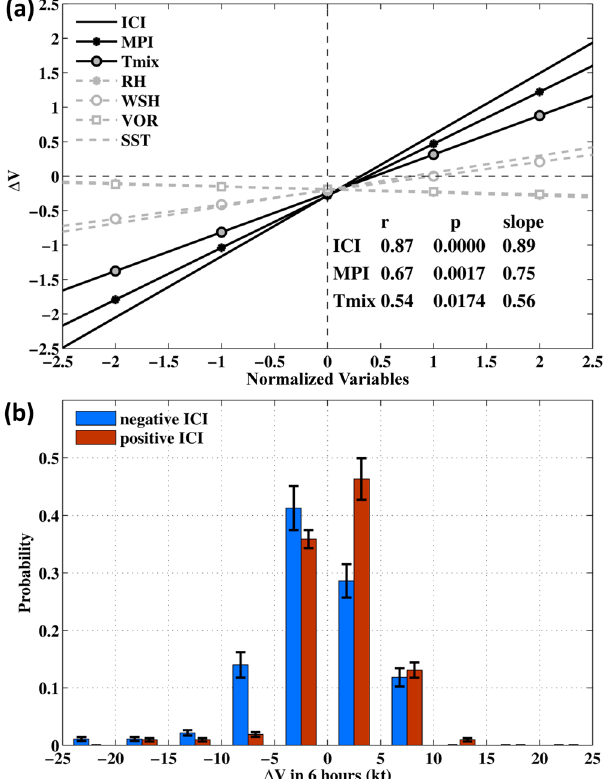
Figure 5. ( a ) Regression lines of normalized (by s.d. σ ) 6-hourly intensity changes ( Δ V) of LSTCs vs . the indicated variables, from 1993 to 2013. Legends show the r , p and slopes for ICI , MPI, T mix which are all significant at the 98% confidence level: shown as solid dark lines; grey dashed lines are for insignificant regressions ( p ≥ 0.53). ( b ) Probability distribution of Δ V sampled by positive and negative ICI s, from 1993 to